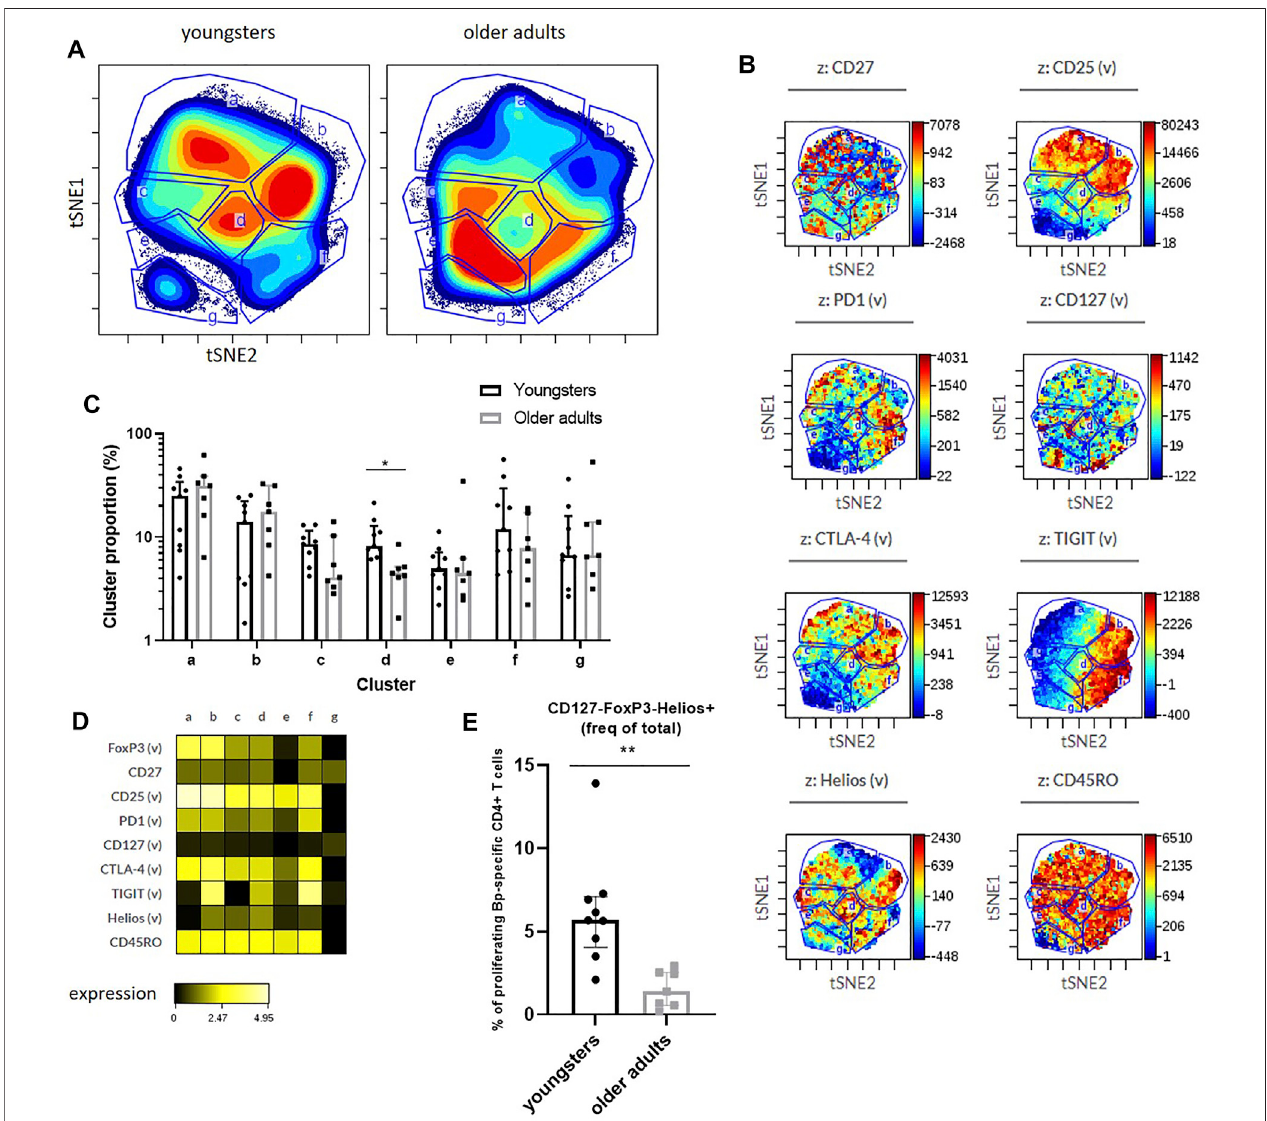
FIGURE 6 | Minor age-related phenotypical differences of proliferated CD4 + T cells responding to Bp132 stimulation in youngsters and older adults in the early phase. (A) Cell density maps show phenotyping analysis by dimensionality reduced single cell data by viSNE show clustering of populations within the proliferating cells of youngsters and older adults of pooled fl ow cytometry data fi les pre-gated on proliferating CD4 + T cells and identi fi ed clusters indicated with letters a-g. (B) Dot-plot z -axis showsthe location and intensities ofeach markerwithin theidenti fi edclusters. (C) Frequenciesofidenti fi edviSNEclusters, based ontheir identifyingmarker expression as indicated, were compared on individual levels via FlowJo analysis. Bars represent median frequency of proliferated CD4 + T cells with interquartile range. Cluster proportions in youngsters and older adults as indicated identi fi ed by vISNE analyses. (D) Heatmap showing Arcsinh-transformed median expression of markers within each cluster of the viSNE plots of youngsters and older adults. (E) Frequencies of CD127 - FoxP3 - Helios + proliferated CD4 + T cells in youngsters and older adults. Statistical signi fi cance was calculated with Mann Whitney U -test. * (cid:1) p < 0.05, ** (cid:1) p < 0.01.